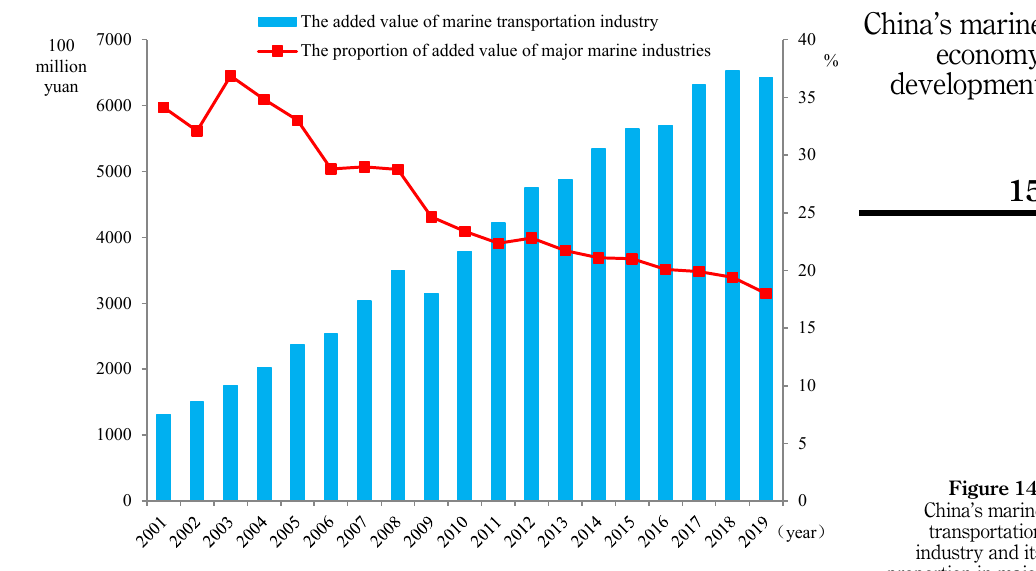
Figure 14. China ’ s